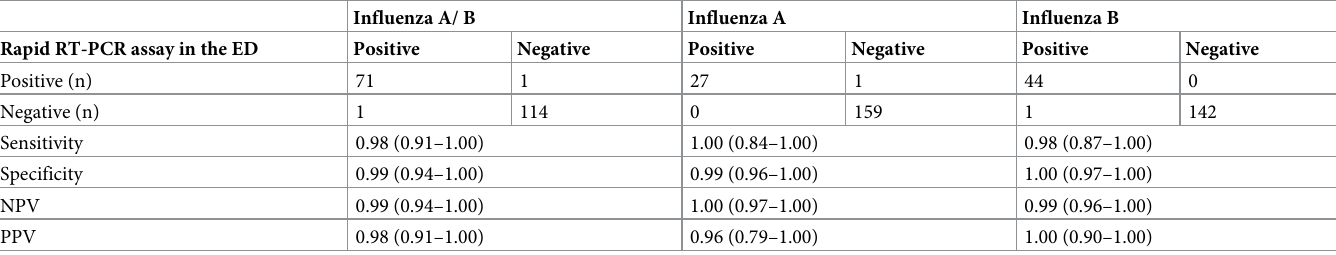
Table 2. Performance characteristics of the RT-PCR assay performed at